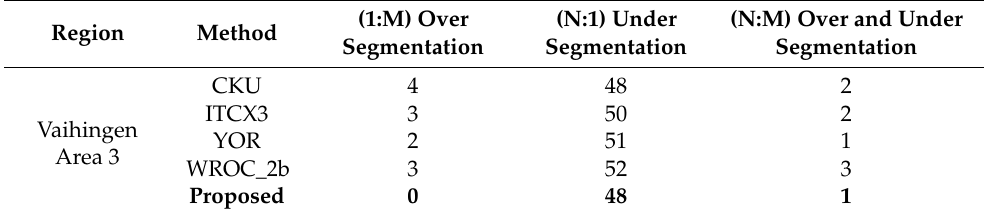
Table 5. Comparison of topological errors between the reference and reconstructed (reference: Results). Region Method